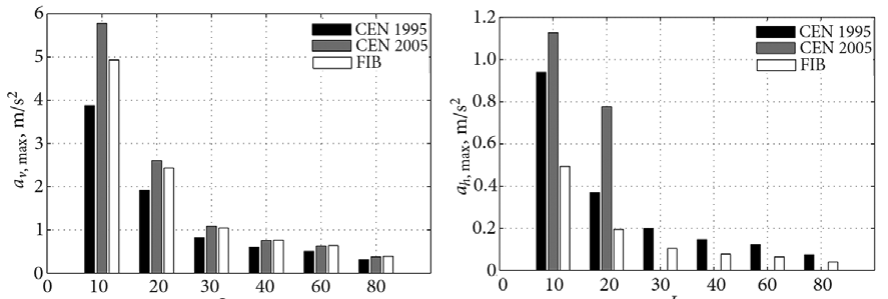
Fig. 7. Vertical and lateral accelerations induced by a group of